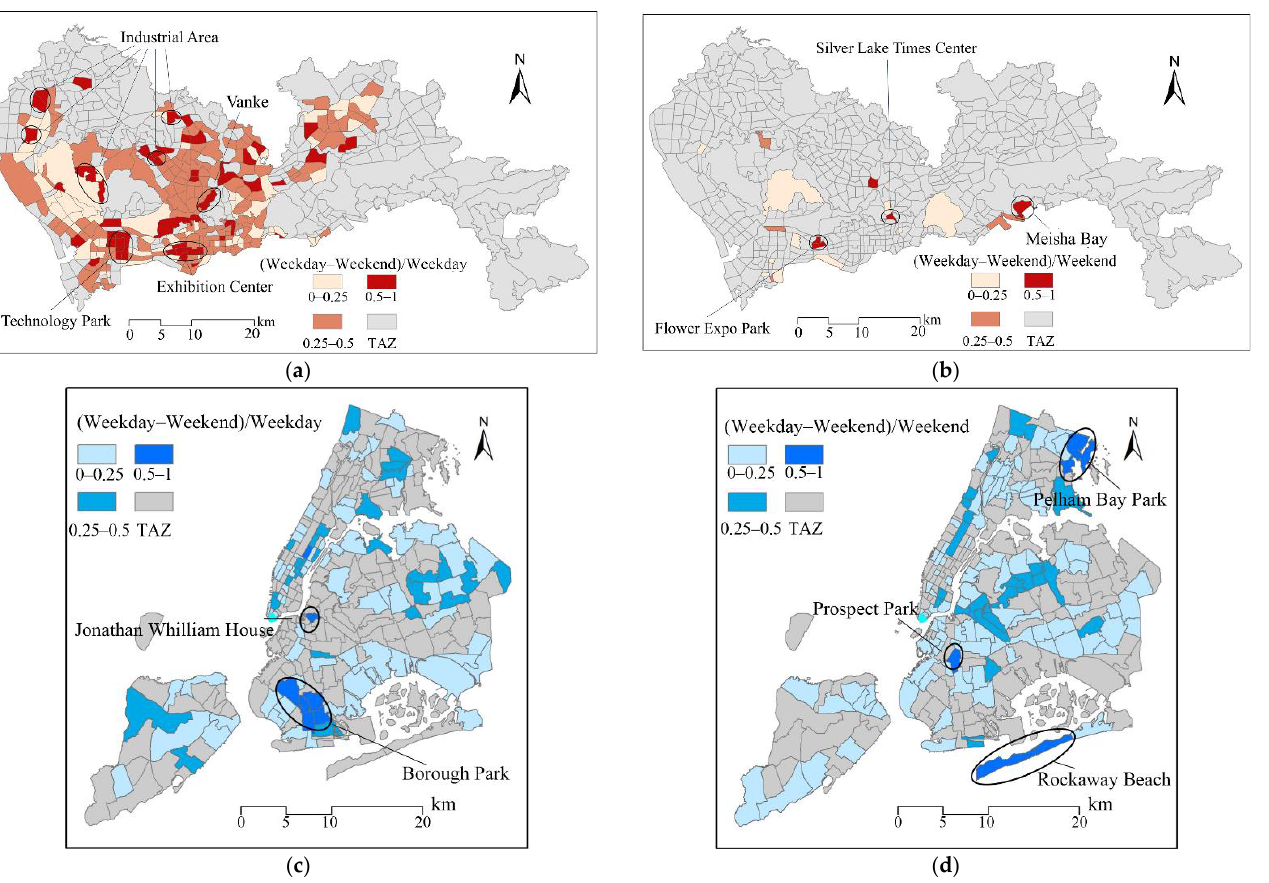
Figure 10. Normalized difference of OD volume. ( a ) Normalized difference between weekday and weekend in Shenzhen. ( b ) Normalized difference between weekend and weekday in Shenzhen. ( c ) Normalized difference between weekday and weekend in New York. ( d ) Normalized difference between weekend and weekday in New York.